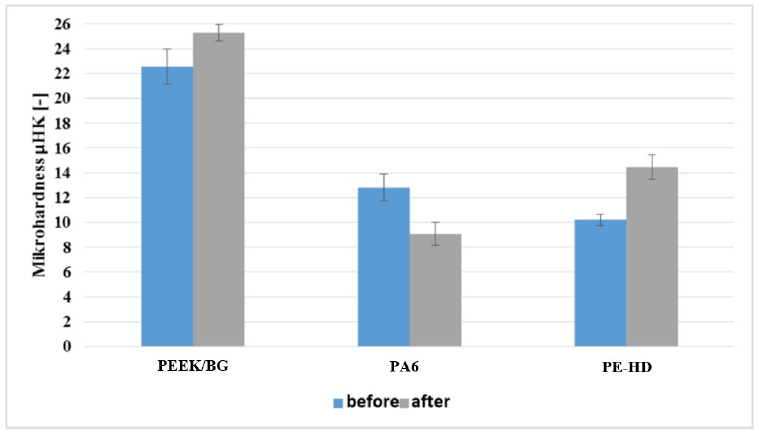
Figure 8. Polymeric material surface microhardness of PEEK/BG, PA6, and PE-HD before and after friction process.